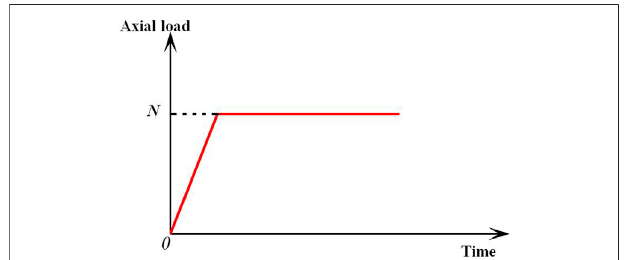
FIGURE 3 | Loading system of axial load.